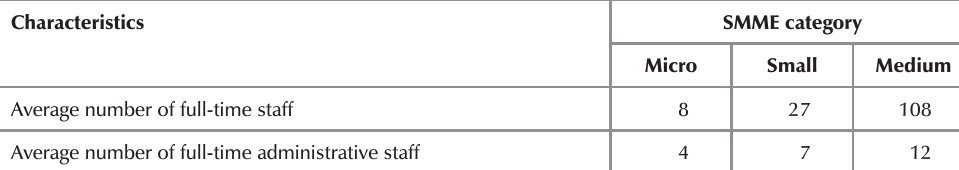
Profile of participating business services SMMEs by number of employees